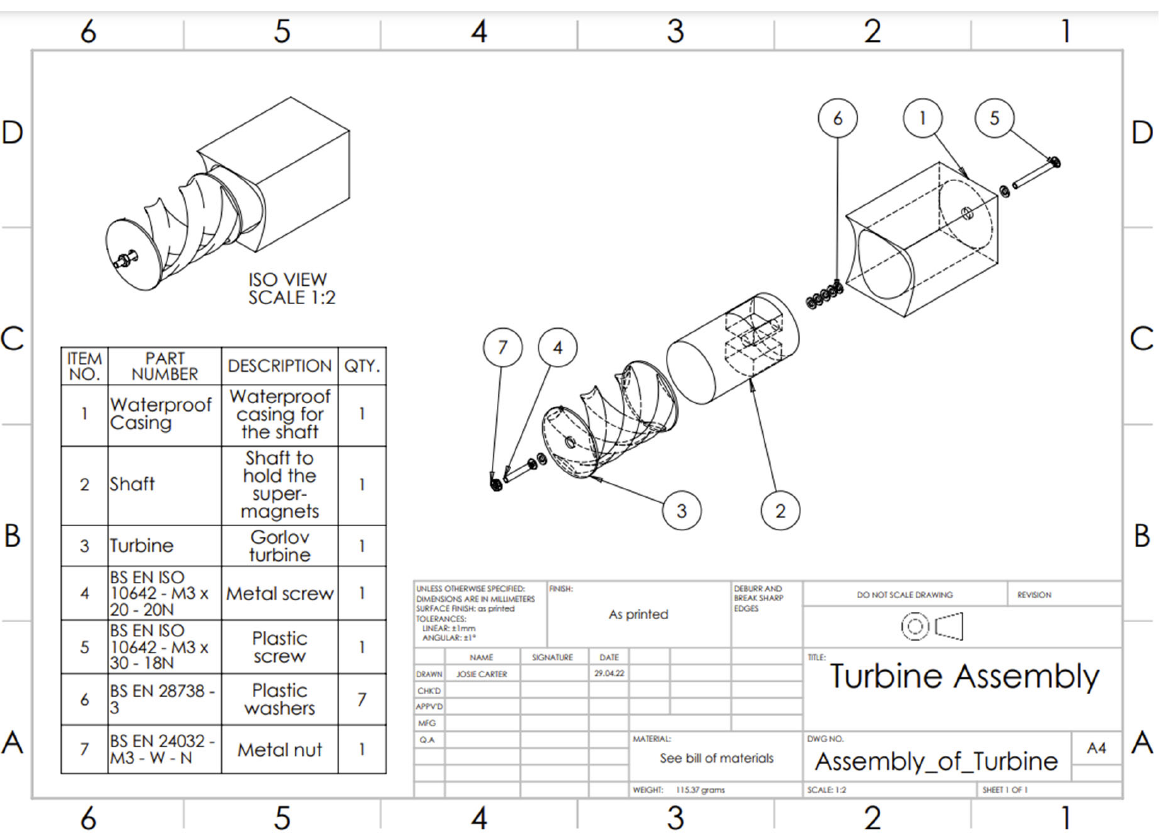
Figure 7. Turbine system assembly drawing.